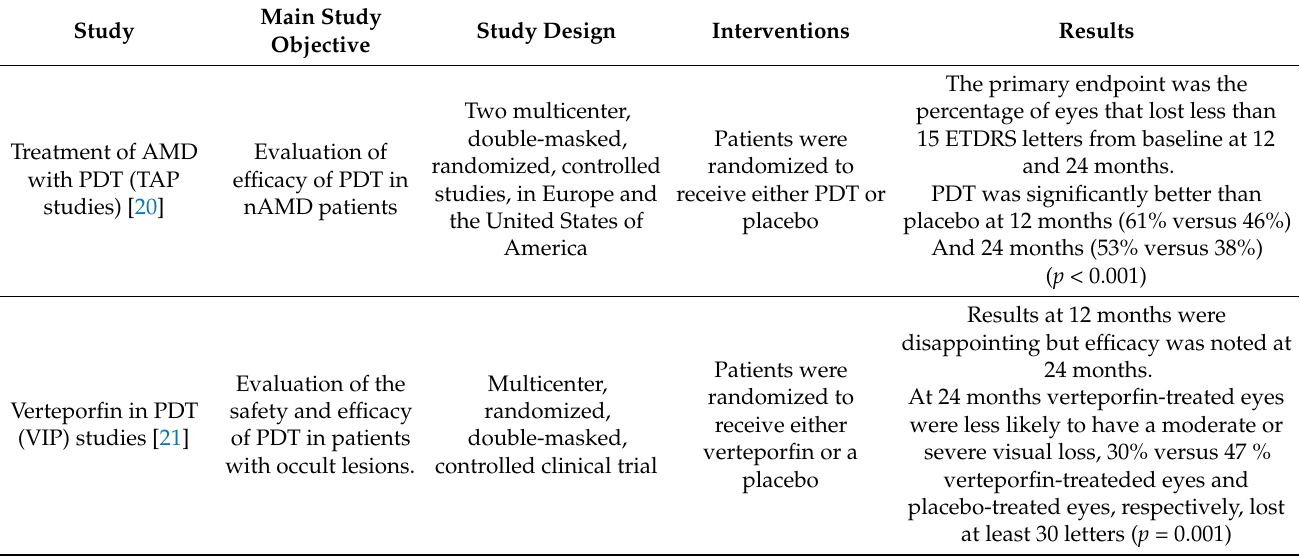
Table 1. Summarizes the important studies evaluating the safety and efficacy of